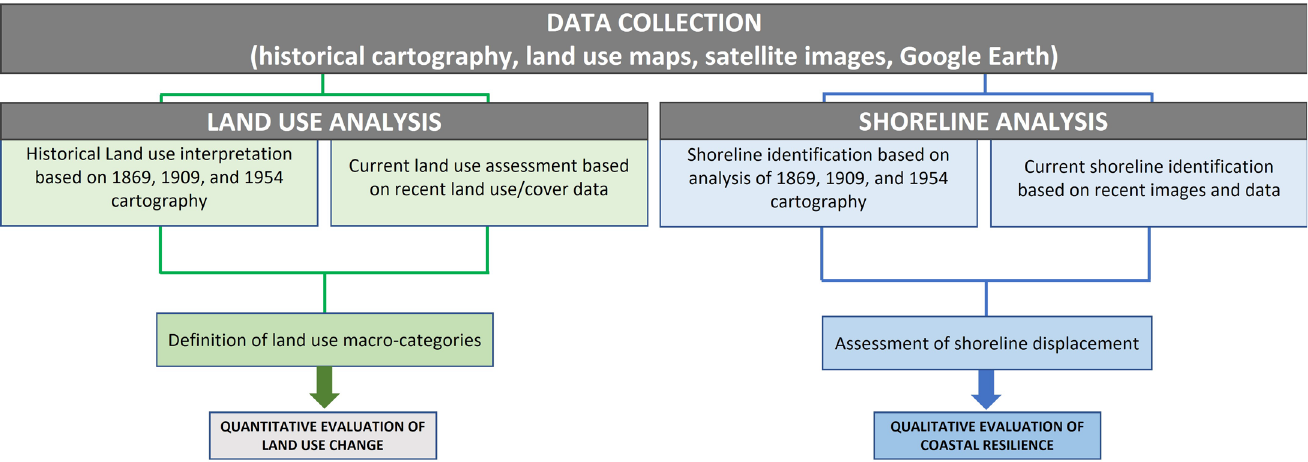
Figure 3. Methodological approach proposed for the quantitative assessment of land use change and the quality evaluation of potential coastal resilience.